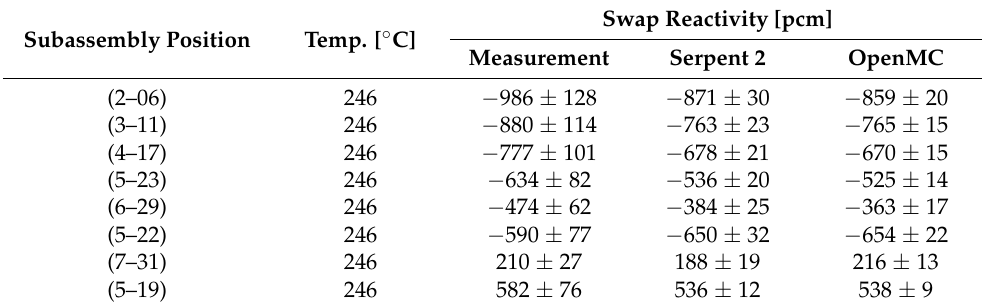
Table 9. Results of swap reactivity with multiple rods.